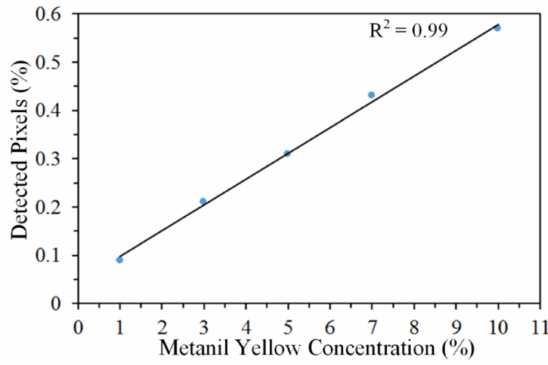
Figure 9. Relationship between actual metanil yellow concentration in samples and the percentage of detected pixels in 1147 cm − 1 binary